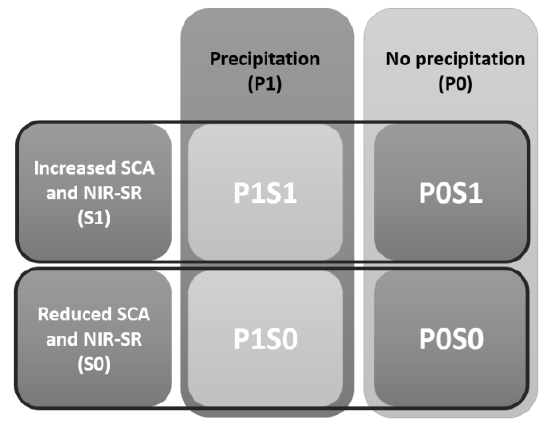
Figure 2. Classification of events based on precipitation and snow changes.